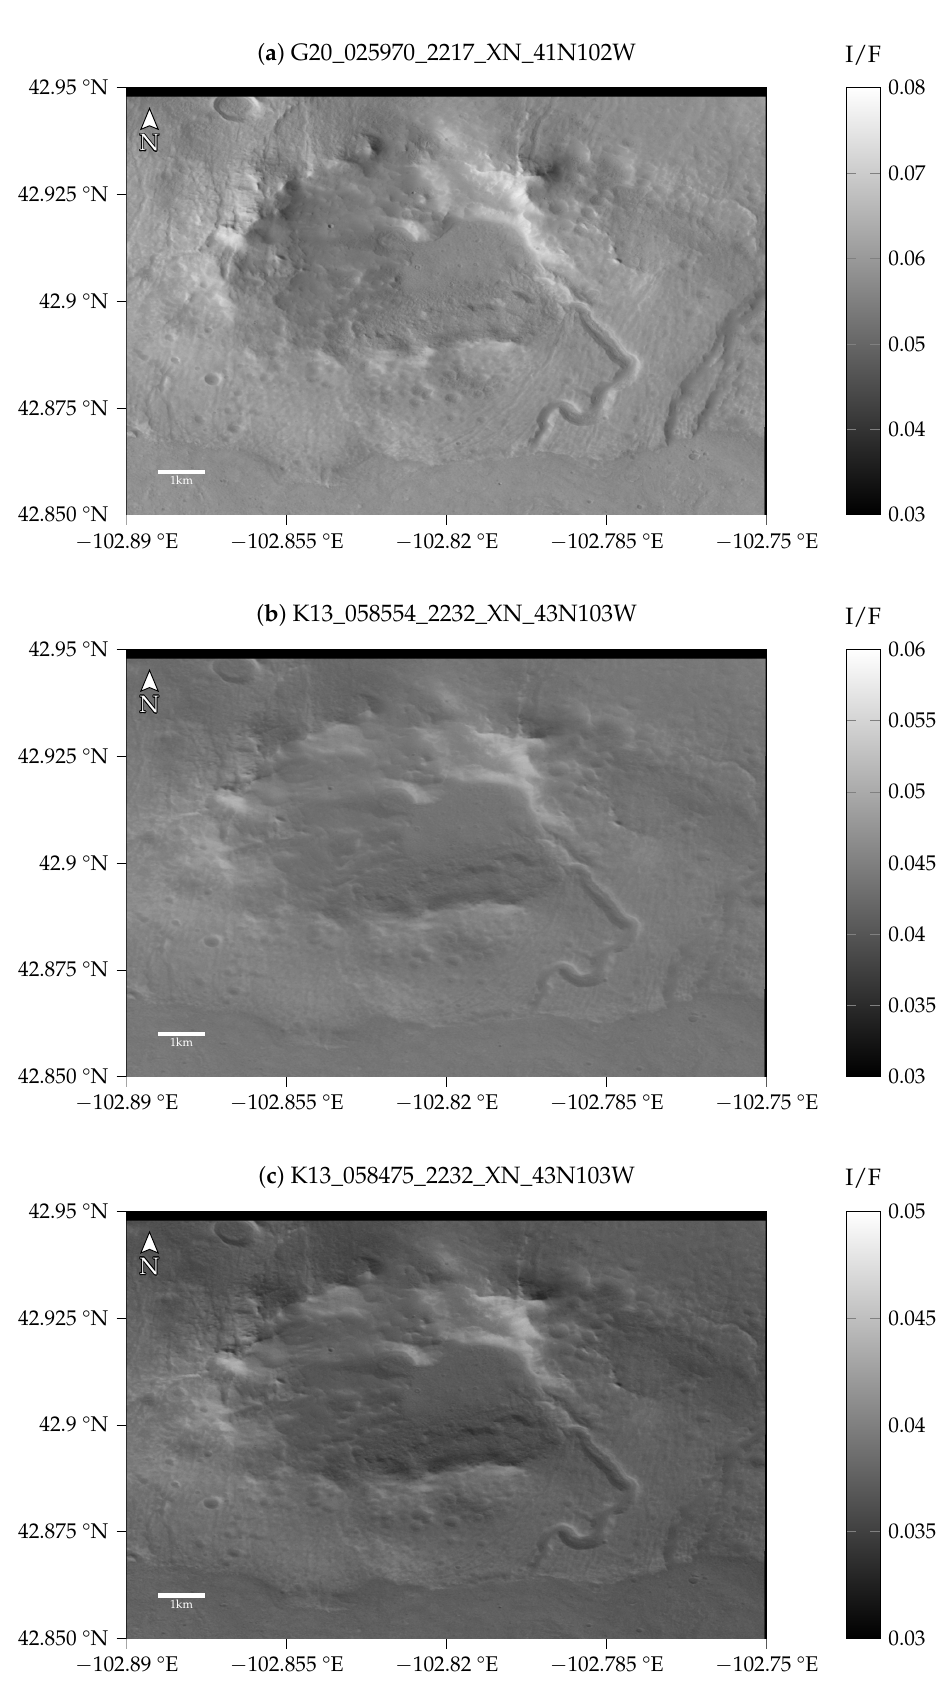
Figure 3. Images of the region of interest inside of the crater northeast of Alba